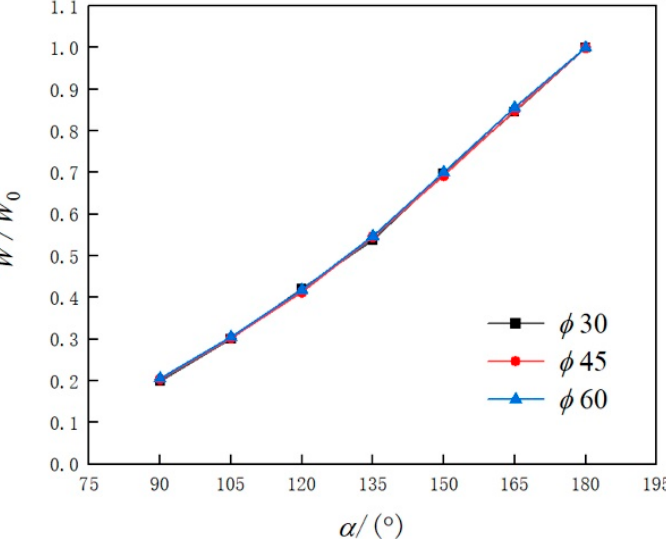
Figure 16. Relative consumed weight W / W 0 changing with the central angle α for straight pipes.